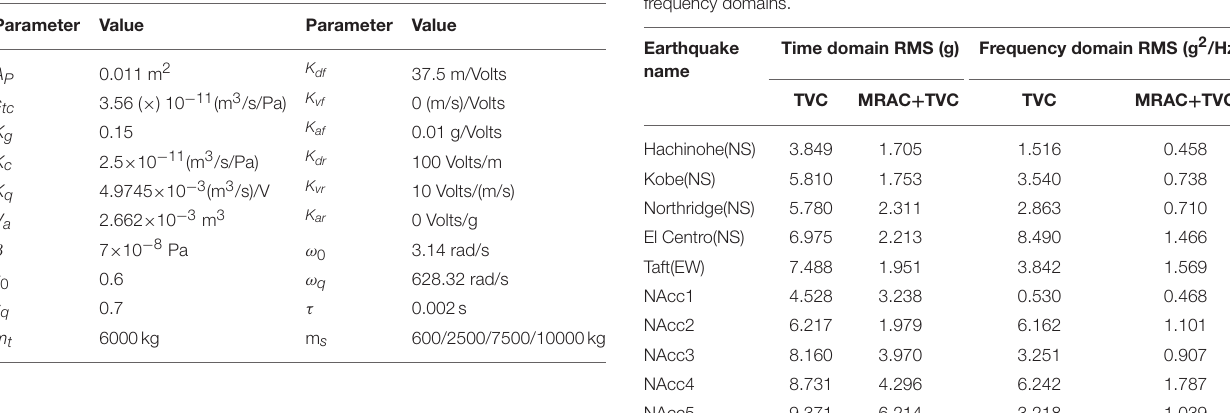
TABLE 1 | Main parameters of shaking table system. TABLE 2 | RMS of acceleration error for a payload of 10,000kg in time and